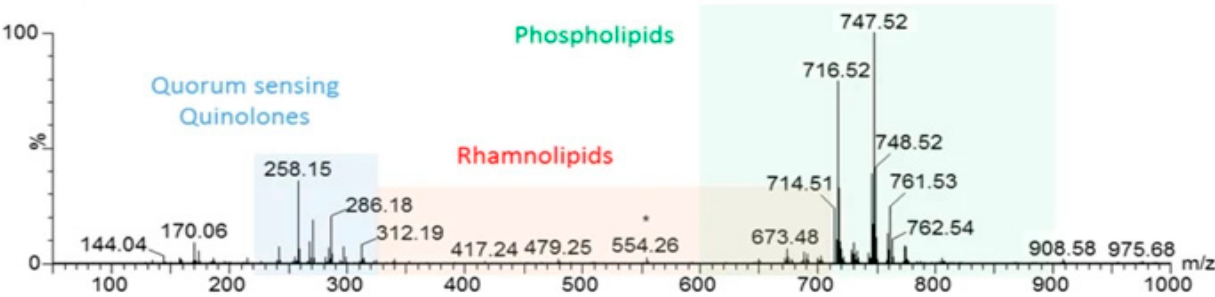
Figure 4. P. aeruginosa REIMS mass spectral output showing the presence of typical phospholipids and the additional rhamnolipid and quorum sensing molecules, reproduced from [106]. The * indicates the peak of the leucine enkaphalin which is used a mass standard for REIMS.